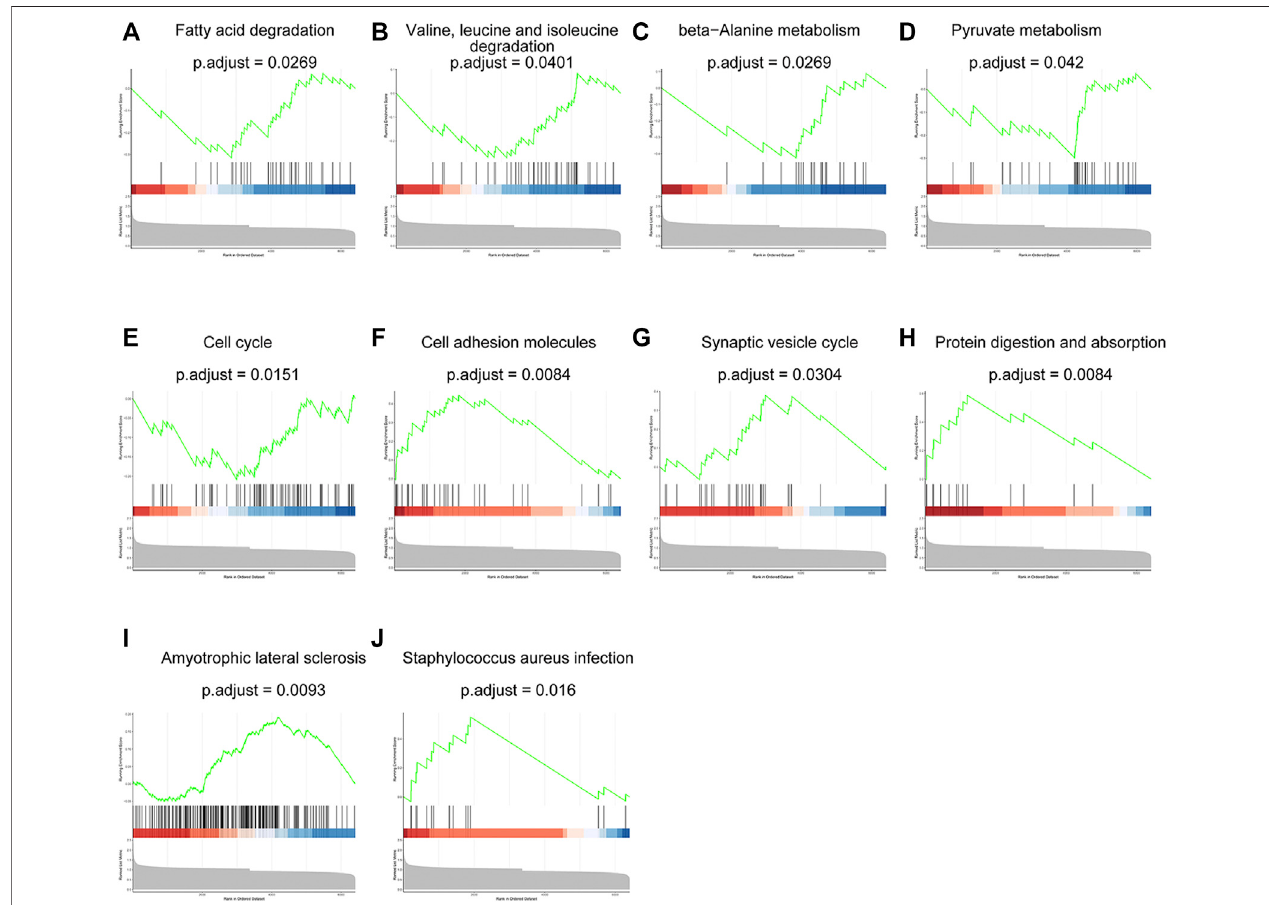
FIGURE 4 | The results of GSEA analysis showed ten dysregulated proteins-related pathways. Fatty acid degradation (A) , valine, leucine and isoleucine degradation (B) , beta-Alanine metabolism (C) , pyruvate metabolism (D) , cell cycle (E) , cell adhesion molecules (F) , synaptic vesicle cycle (G) , protein digestion and absorption (H) , amyotrophic lateral sclerosis (I) and staphylococcus aureus infection (J) .